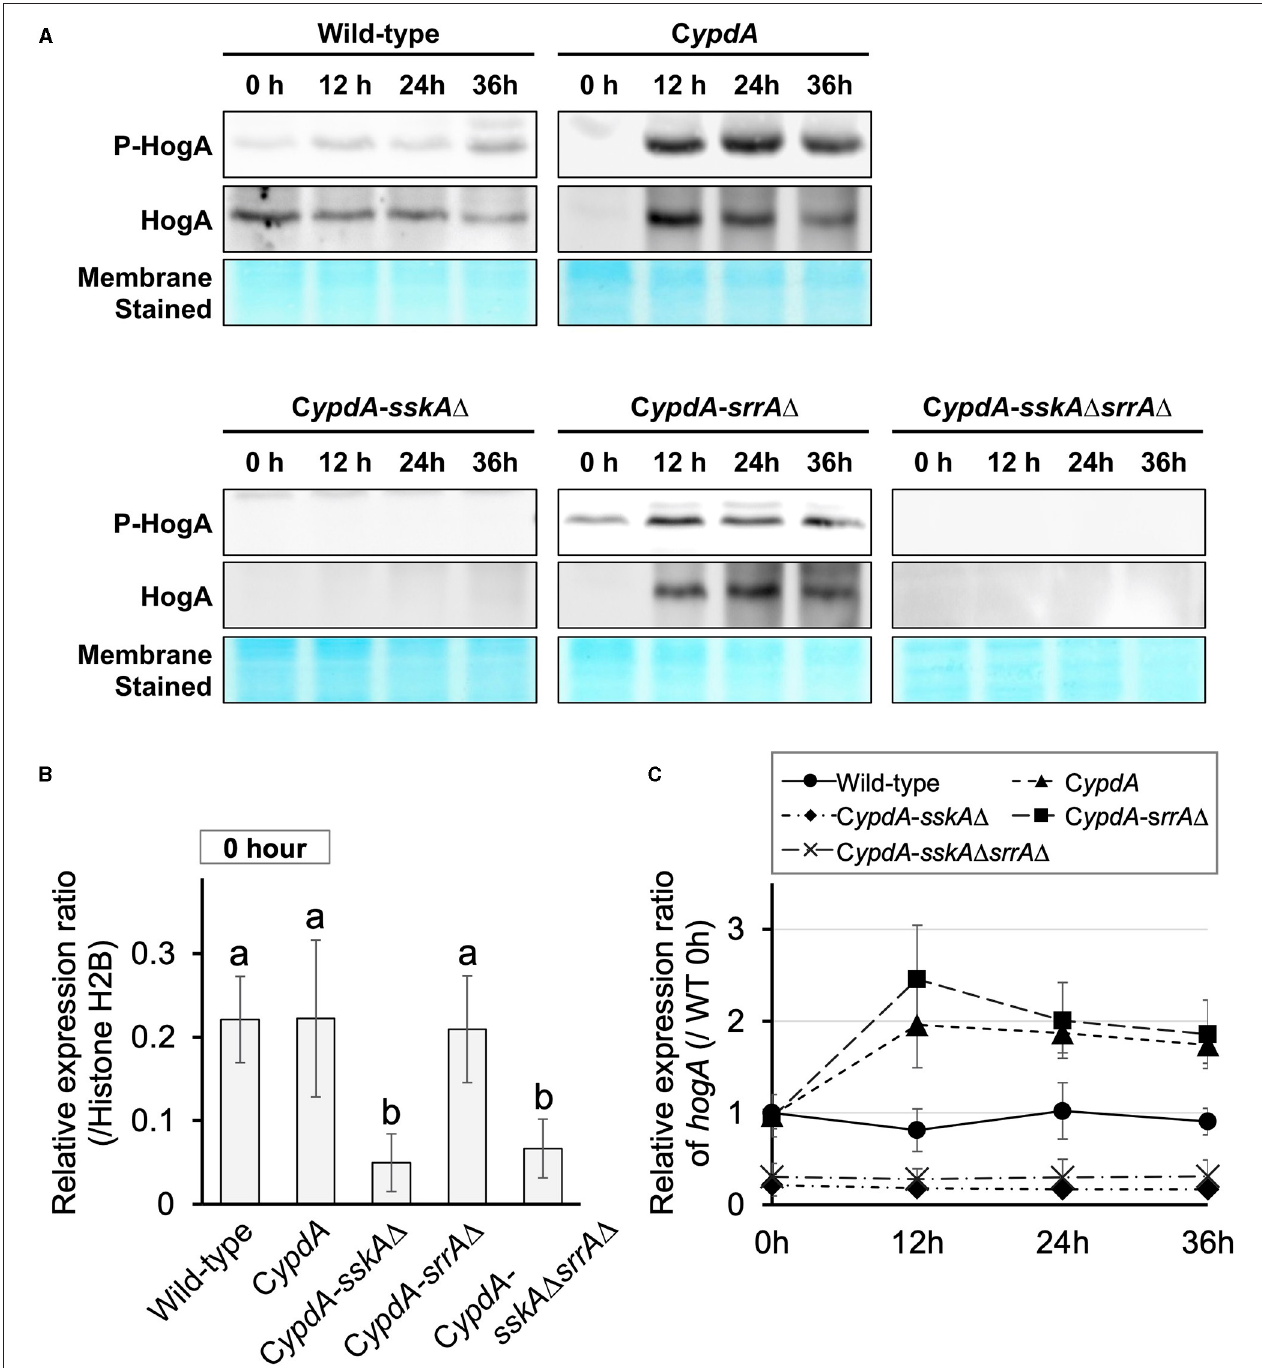
FIGURE 3 | Phosphorylation of HogA protein (A) and gene expression of hogA (B,C) in Aspergillus nidulans wild-type, C ypdA , and C ypdA -derivative strains. (A) Western blot analysis of phospho-HogA. HogA protein and stained membrane for confirmation of protein transfer are shown. Samples were prepared from mycelium at 12, 24, and 36h after transfer from ypdA -inducing medium (CDTFY; 0h) to ypdA -repressing medium (CDY). Each lane was loaded with 15 µ g protein. (B) Quantitative real-time PCR analysis. Conidia (final concentration, 5 × 10 5 conidia/ml) were cultured in ypdA -inducing CDTFY for 20h before transfer to ypdA -repressing CDY medium, at 0h. Transcript levels of hogA were quantified by RT-PCR. Each value represents the expression ratio relative to that of the gene encoding histone H2B in each strain. Error bars represent standard deviations from three independent replicates. Different letters indicate significant differences by Tukey–Kramer’s test ( P < 0.05). (C) Time course of hogA expression after transfer from ypdA -inducing medium (CDTFY; 0h) to ypdA -repressing medium (CDY). Samples were prepared from mycelia at 12, 24, and 36h, and expression of hogA was quantified by RT-PCR. The expression level of the hogA gene in each sample was normalized to that of the histone H2B gene (internal control) in the same sample. Each value represents the hogA expression ratio relative to expression in the wild-type strain cultured in CDTFY medium for 20h (WT 0h). Error bars represent standard deviations from three independent replicates.